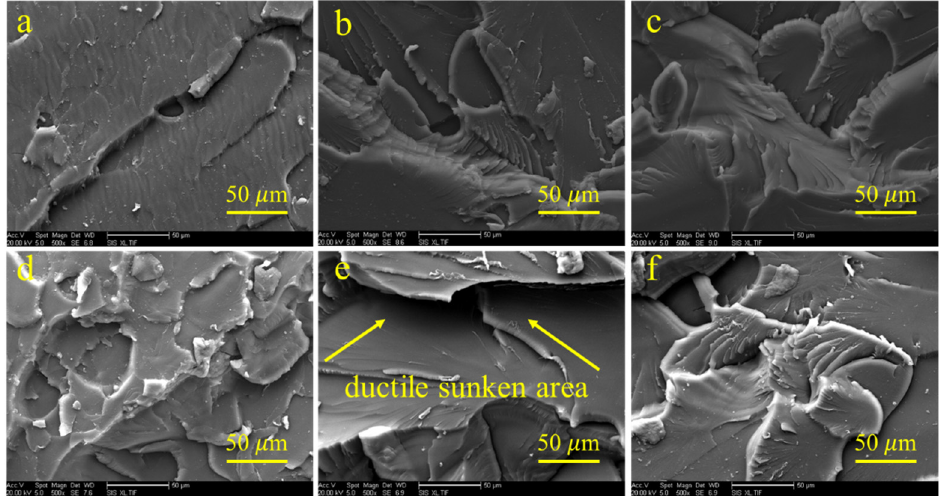
Figure 7. The morphology of the fractured surface of unmodified BMI and HBPI modified BMI after impact test. ( a ) pure BMI, ( b – f ) modified BMI with 10 wt.%, 20 wt.%, 30 wt.%, 40 wt.%, 50 wt.%